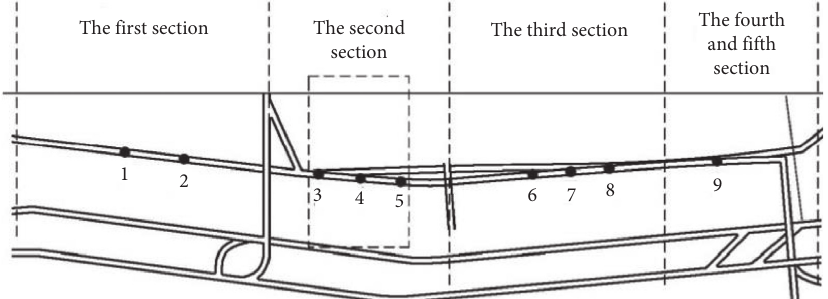
Figure 2: Location of the hydraulic punching test area of 27001-floor return airway.